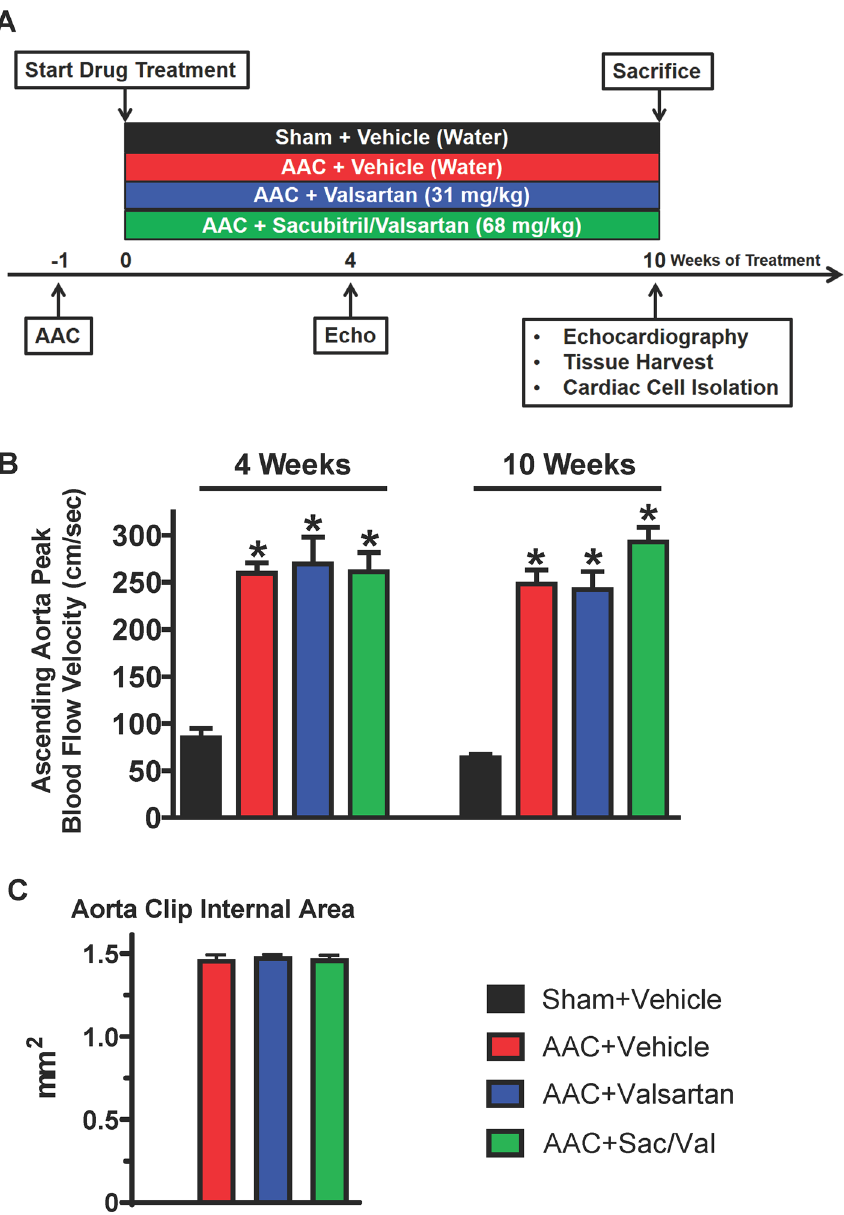
Figure 1. Validation of the AAC rat model and LV pressure overload among AAC experimental groups. ( A ) Experimental design for in vivo treatments: rats were subjected to AAC or sham operation 1 week before treatment with vehicle, valsartan, or sacubitril/valsartan at indicated doses by oral gavage for 10 weeks. Echocardiographic measurements were performed at indicated time points, followed by tissues harvest or cardiac cell isolation after 10-week treatment. ( B ) Ascending aorta peak blood flow velocity after 4-week ( left ) and 10-week ( right ) treatment. Mean ± SEM. N = 8–11 rats per group. * P < 0.05 versus respective Sham + Vehicle. ( C ) The internal area of the aorta clips from different AAC groups. Mean ± SEM. N = 8–11 rats per